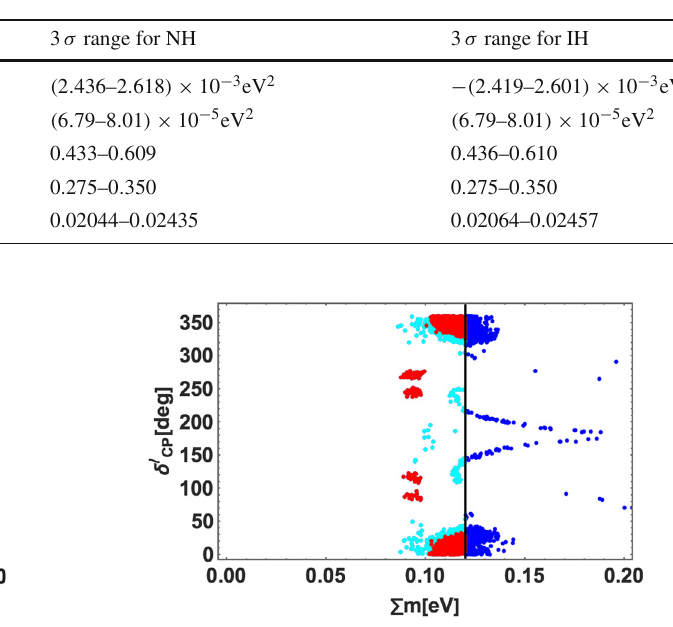
Fig. 4 Allowed regions of τ . PMNS mixing angles are reproduced at cyan, blue and red points while CKM are reproduced at green points. At cyan (blue) points, the sum of neutrino masses is below (above) 120meV. At red points, both CKM and PMNS are reproduced with the sum of neutrino masses below 120meV. The solid curve is the boundary of the fundamental domain, | τ | = 1